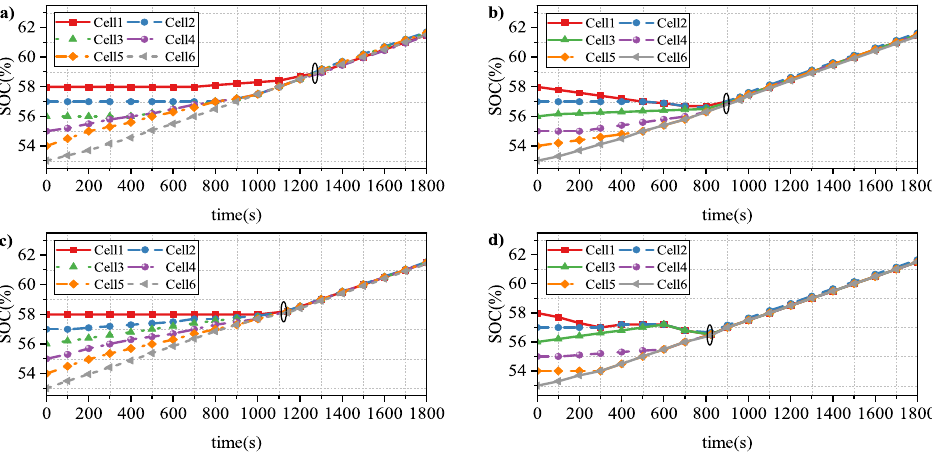
Figure 11. Equalization process of four circuits in charging state: ( a ) Pattern 1; ( b ) Pattern 2; ( c ) Pattern 3; and ( d ) Pattern